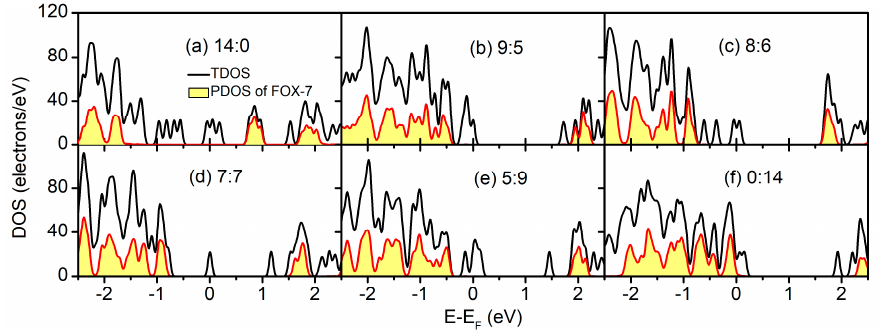
Figure 5. Total density of states (TDOS) and the constituent partial density of states (PDOS) of the FOX-7–GO composites with different OH:O ratios.